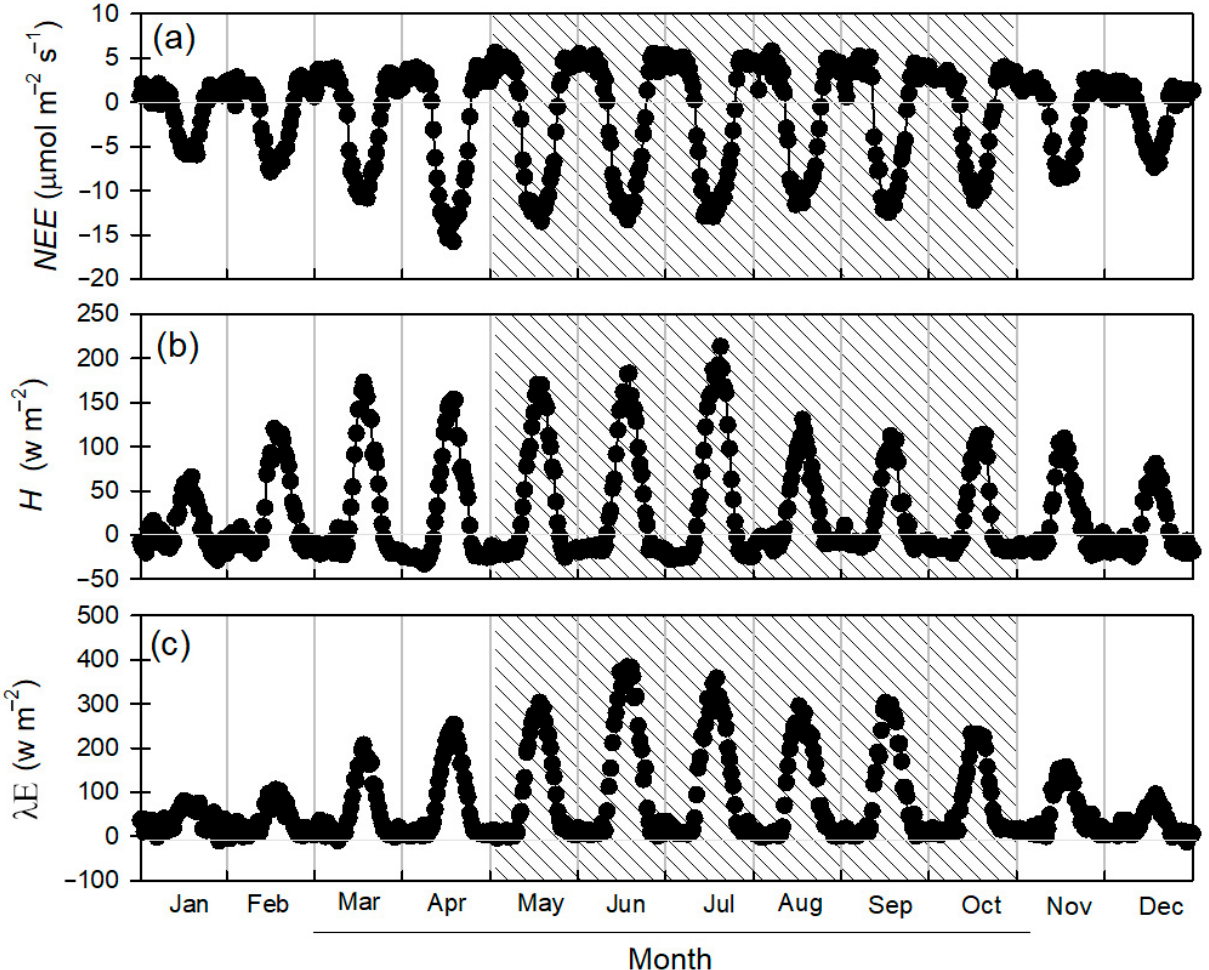
Figure 9. Net ecosystem exchange ( a , NEE ), sensible heat flux ( b , H ), and latent heat flux ( c , λ E ). The shaded area indicates the wet season (May through October).